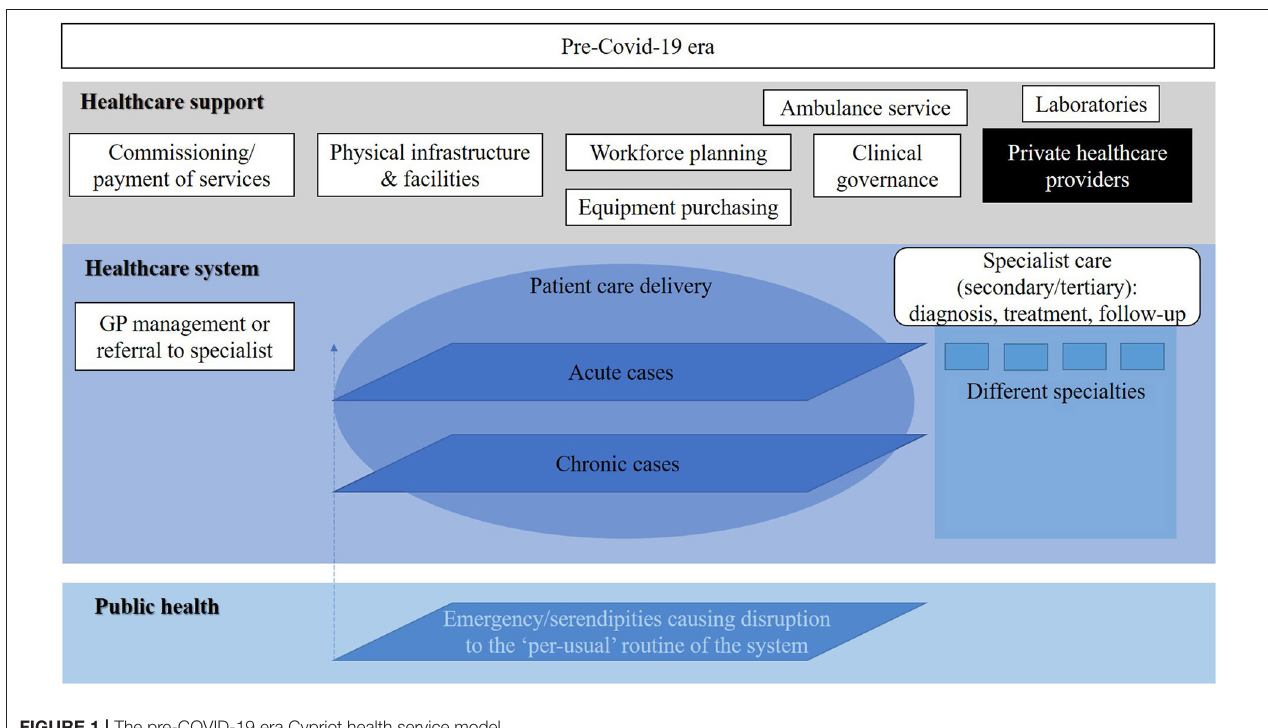
FIGURE 1 | The pre-COVID-19 era Cypriot health service model.